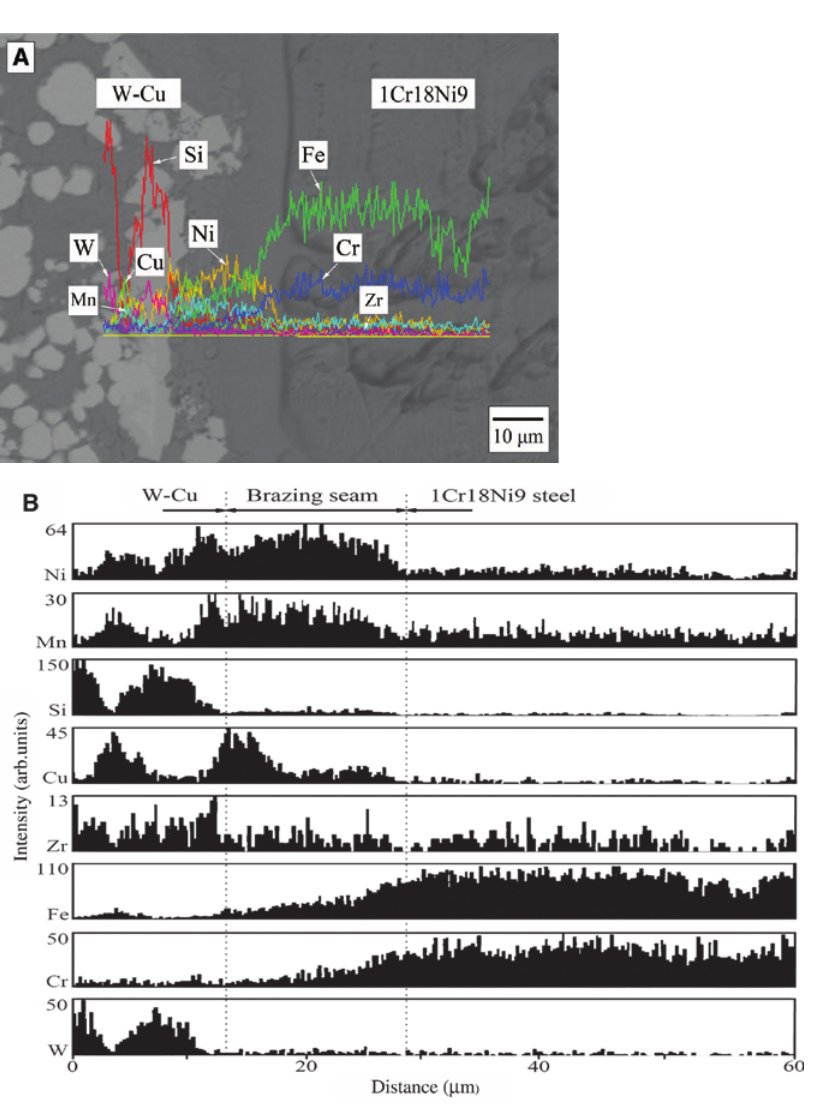
Figure 4: Element distribution near the interface of NiMnSiCuZr brazed joint: (A) line scan location; (B) element